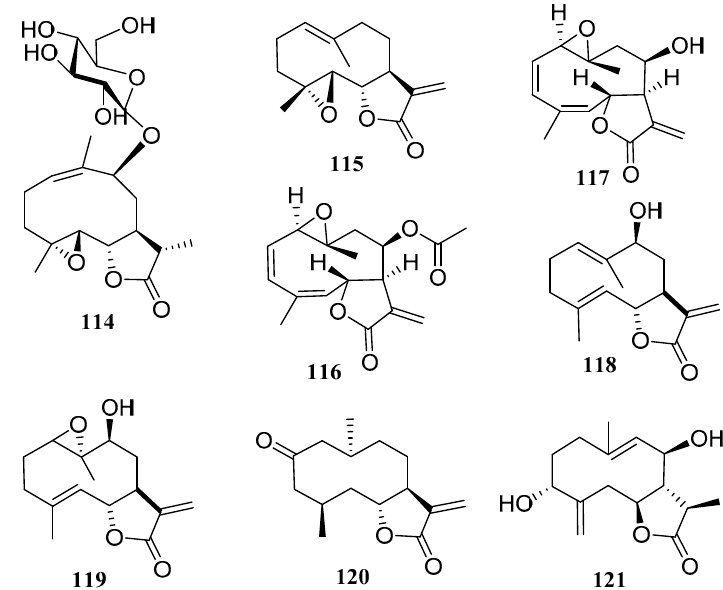
Figure 9. Structures of germacrane-type sesquiterpenoids 114 – 121 .